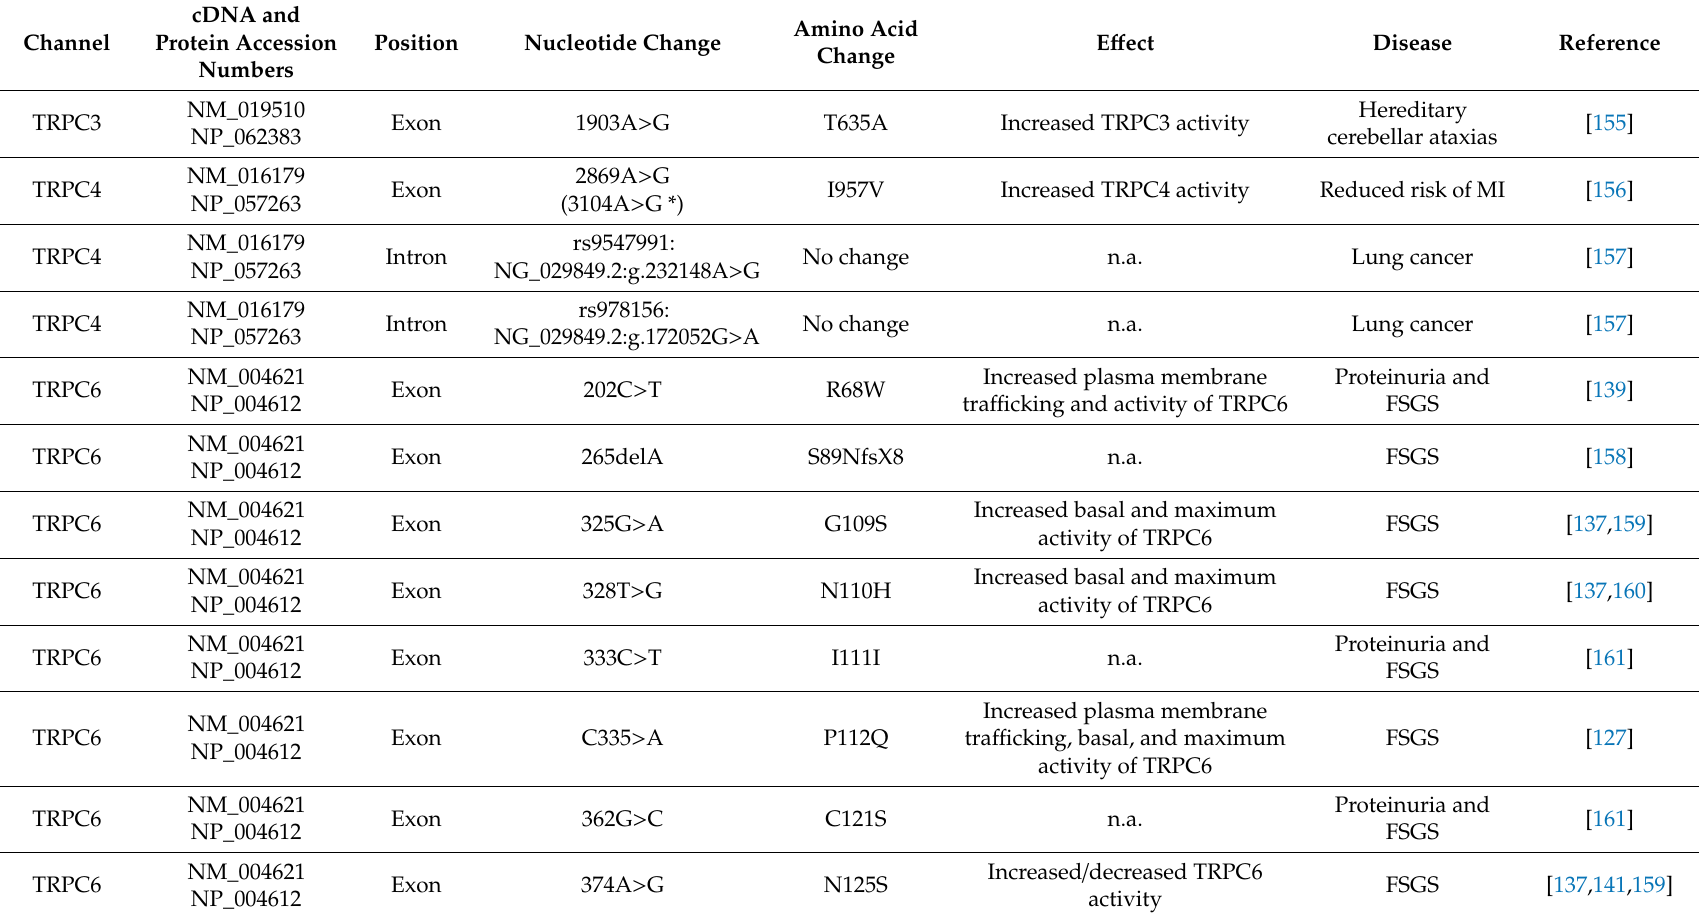
Table 3. Natural mutations and SNPs of di ff erent members of